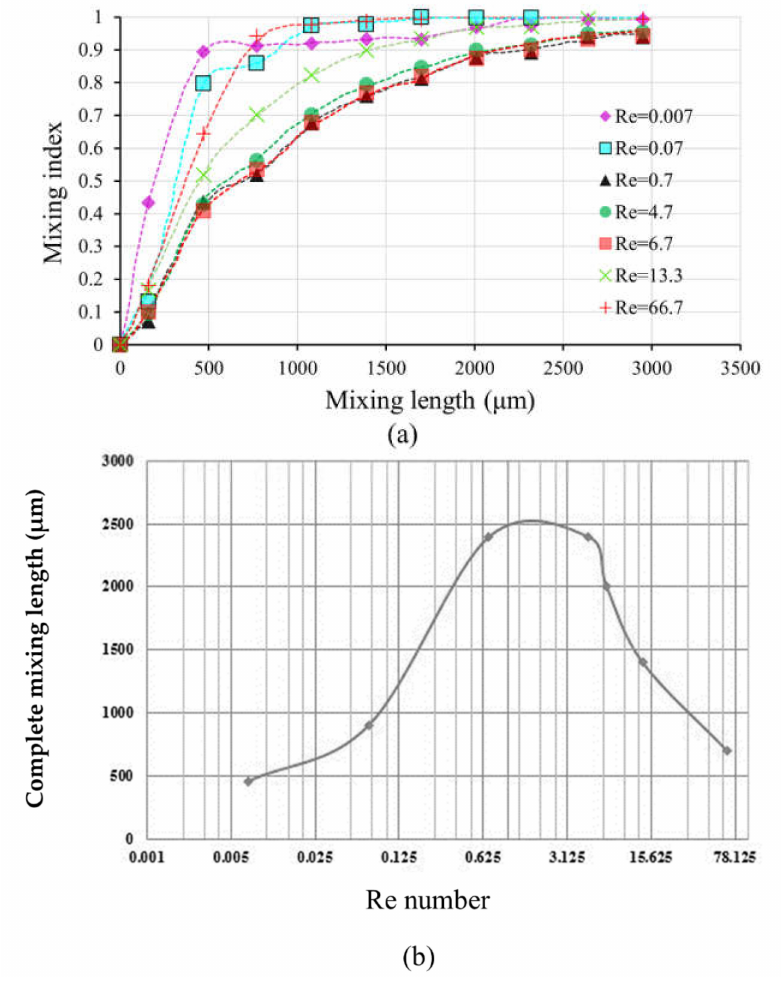
Figure 4. ( a ) The mixing index of each cross-sectional plane in the micromixer at different Re numbers for the normal fluid; ( b ) complete mixing lengths versus Re number in the micromixer for the normal